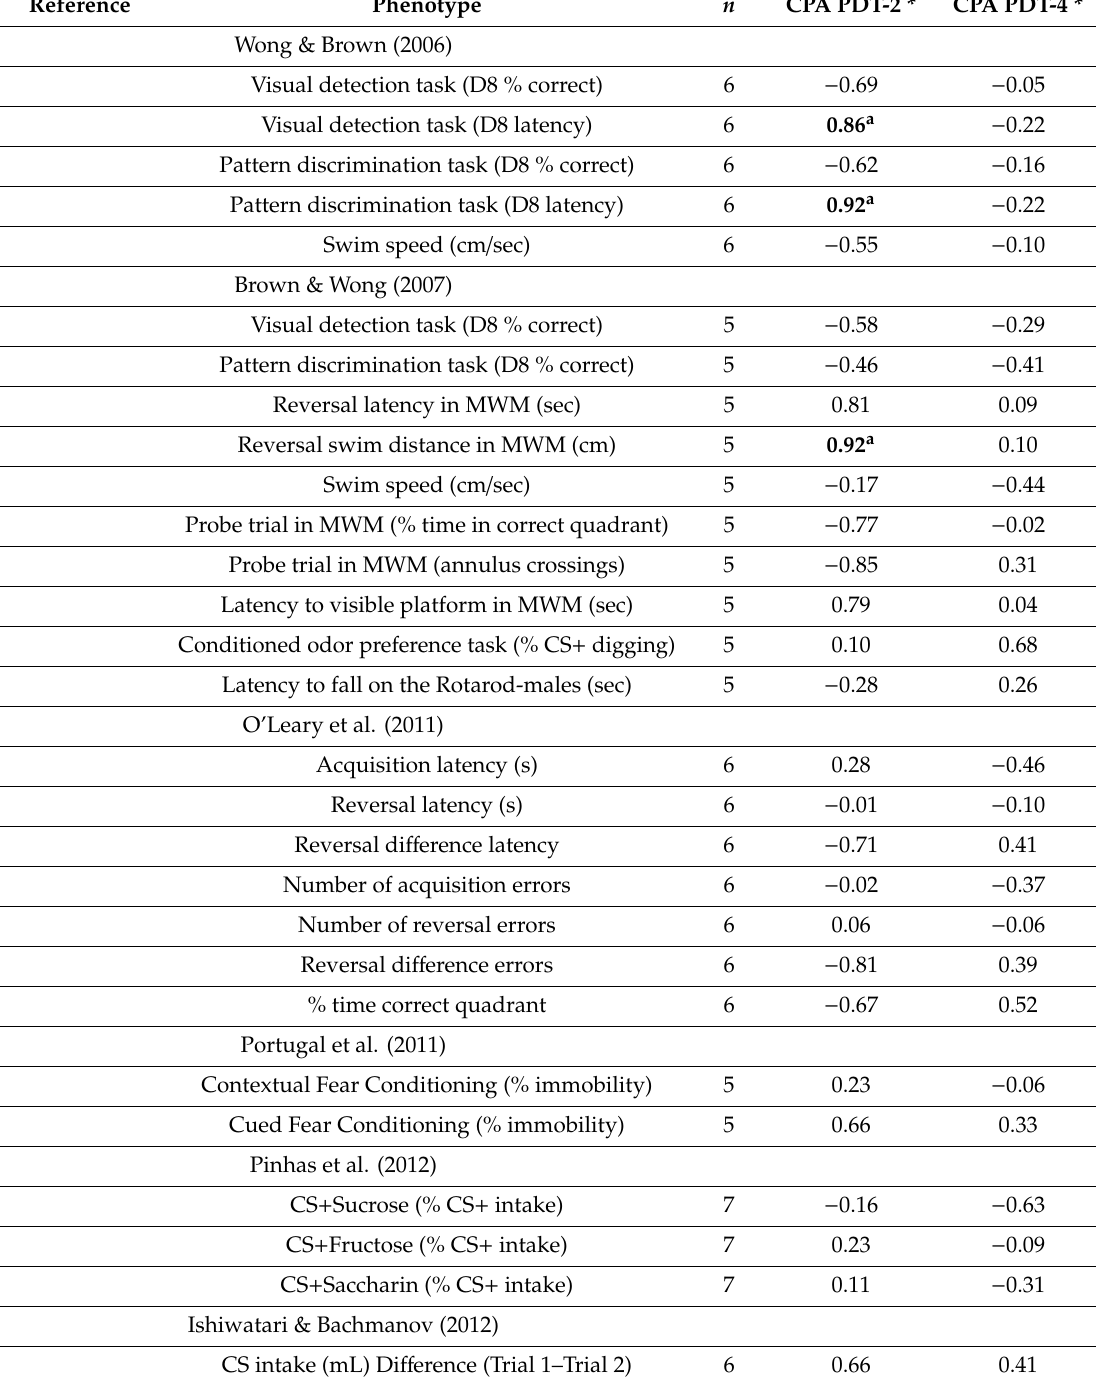
Table 3. Genetic correlations (Pearson r ) between CPA and learning